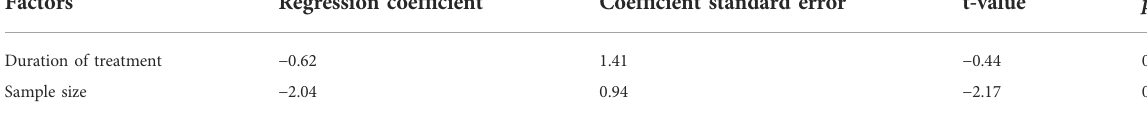
TABLE 2 Meta-regression analysis.